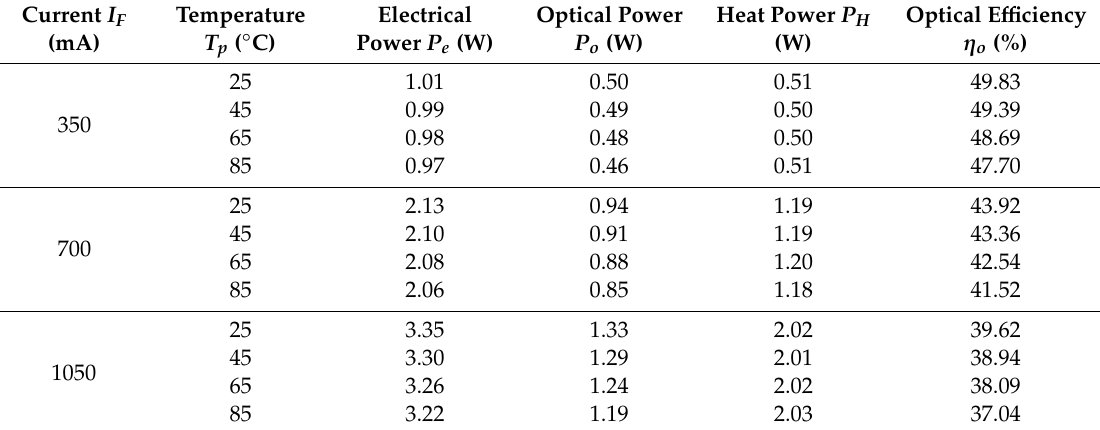
Table 1. Electric power P e , optical power P o , heat power P H and optical e ffi ciency η o for the studied LED source.